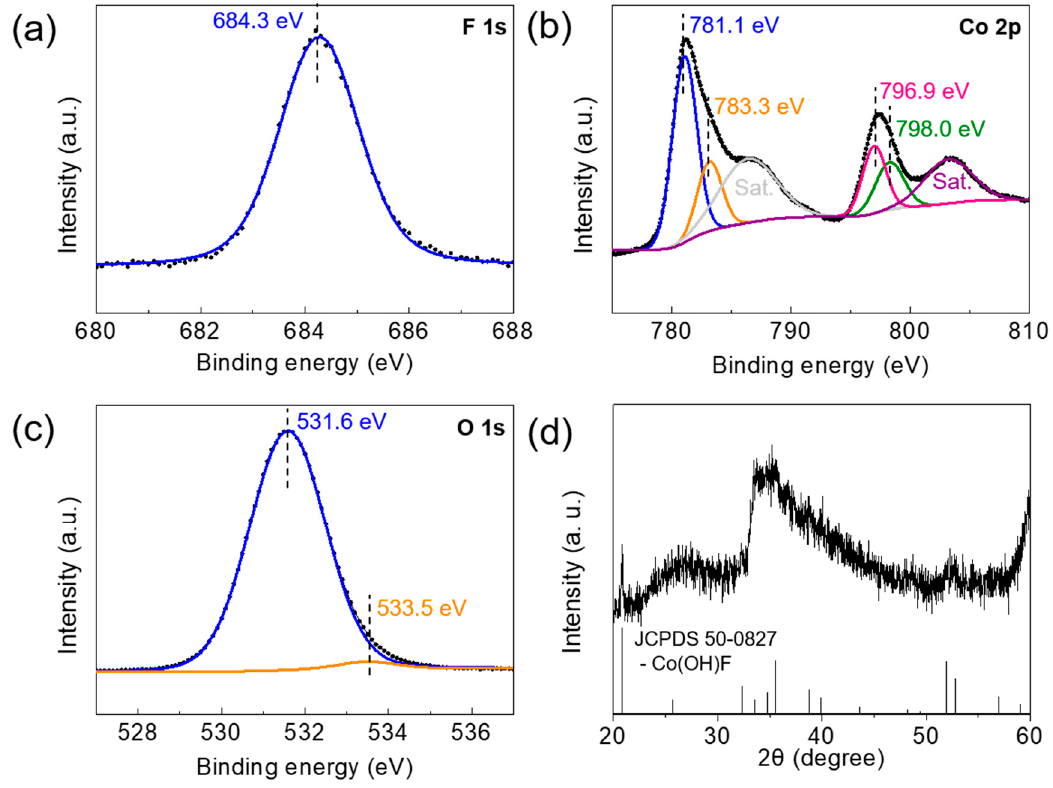
Figure 3. X-ray photoelectron spectroscopy (XPS) spectra of the Co(OH) x F 2 − x nanosheets (( a ) F 1s, ( b ) Co 2p, and ( c ) O 1s), and X-ray diffraction (XRD) pattern of the Co(OH) x F 2 − x nanosheets ( d ).